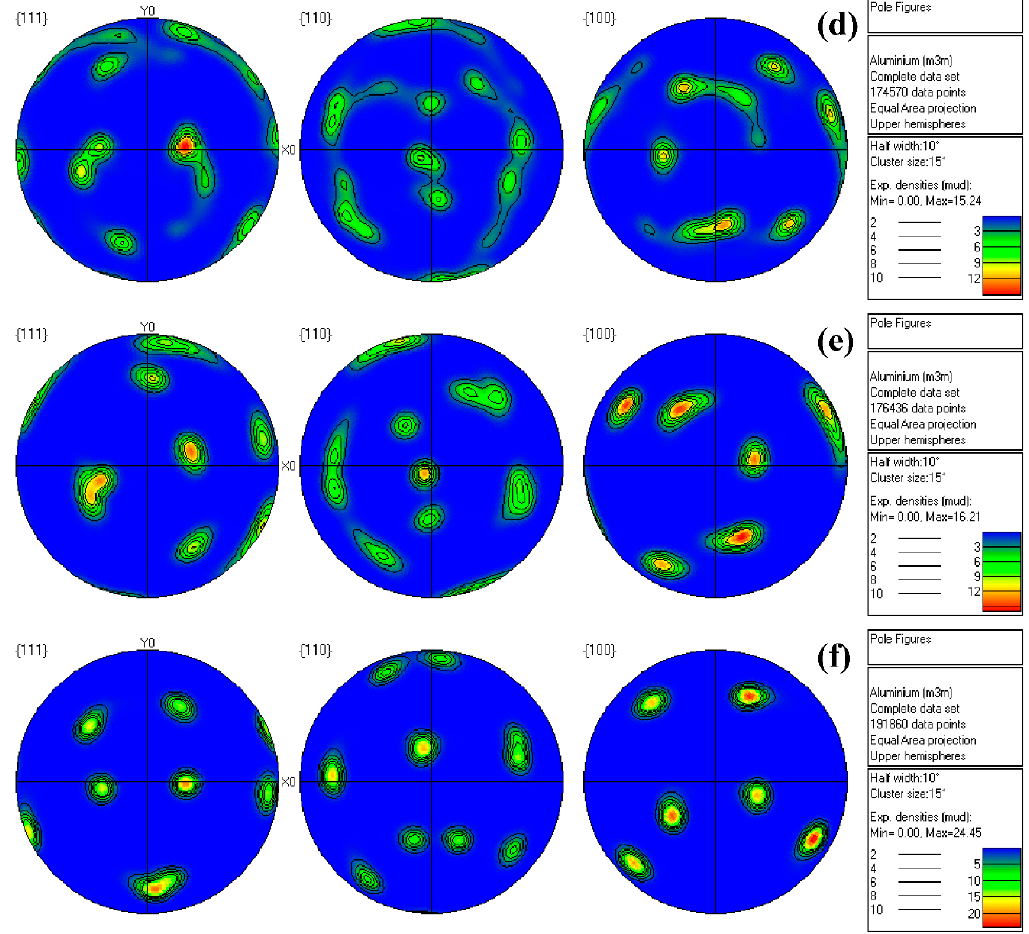
Figure 5. Pole diagram of cold rolled alloys: ( a ) Al-3Mg-0.5Mn; ( b ) Al-3Mg-0.5Mn-0.2Er; ( c ) Al-3Mg-0.5Mn-0.2Zr; ( d ) Al-3Mg-0.5Mn-0.2Cu; ( e ) Al-3Mg-0.5Mn-0.2Si; ( f ) Al-3Mg-0.5Mn-0.2Zn.